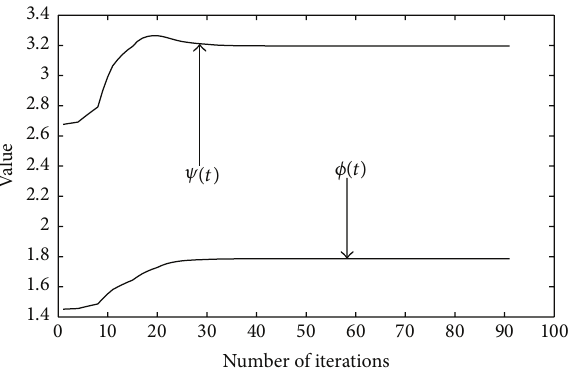
Figure 5: Trajectories of 𝑥(𝑡) , the solution of (10) with initial 𝑥(0) as Figure 4: Trajectories of 𝜙(𝑡) = √−𝑥(𝑡) 𝑇 (𝐴 − 𝐴 𝑇 ) 2 𝑥(𝑡)/4𝑥(𝑡) 𝑇 𝑥(𝑡) (55), which should converge to the imaginary part of an eigenvector and 𝜓(𝑡) = 𝑥(𝑡) 𝑇 (𝐴 + 𝐴 𝑇 )𝑥(𝑡)/2𝑥(𝑡) 𝑇 𝑥(𝑡) based on (10) with initial of 𝐴 corresponding to the eigenvalue 𝜆 3 . | and 𝑎 𝑥(0) as (55), which should converge to |𝑏 3 3 , respectively.